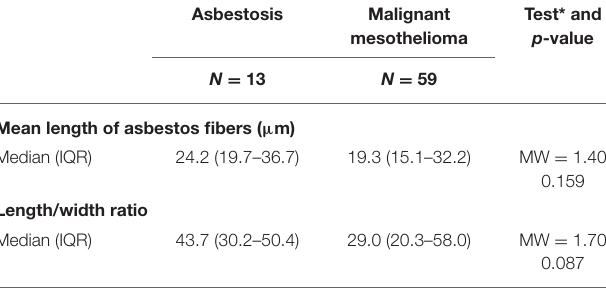
Asbestosis Malignant Test* and p mesothelioma